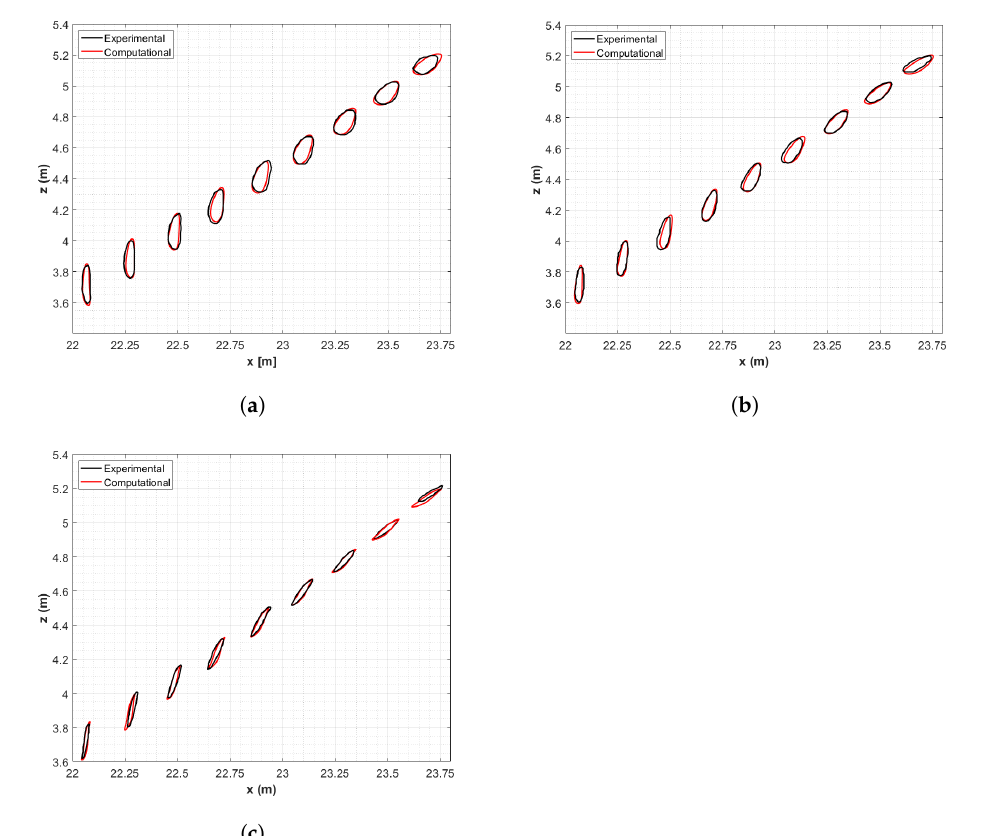
Figure 27. Comparison between computed trajectories of catenary nodes and experimental tracked points for different oscillation periods T = 2.8, 3.5, 5.5 s and amplitude A = 0.125 m for the isolated mooring line with clumped weight (Configuration 1). ( a ) T = 2.8 s. ( b ) T = 3.5 s. ( c ) T = 5.5